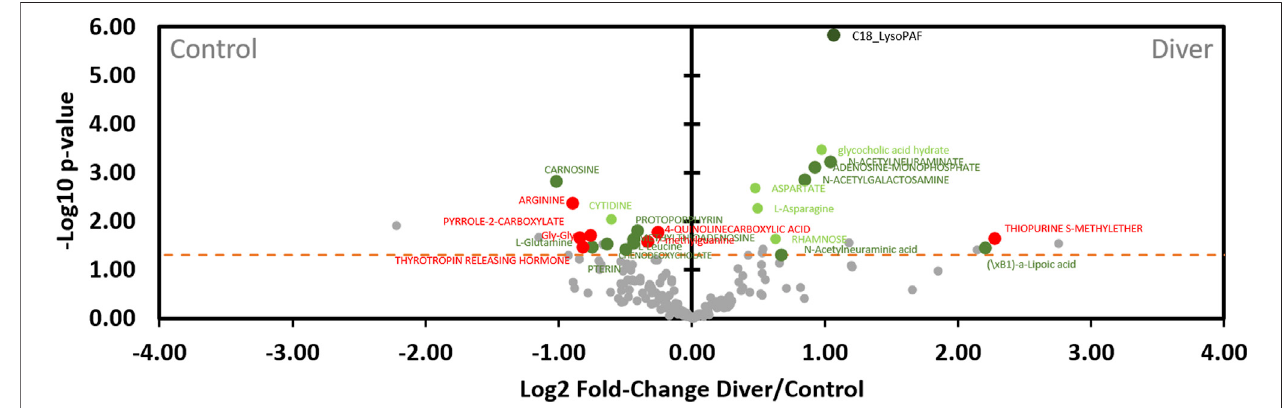
FIGURE 10 | Volcano plot showing metabolomic data in rats ( n = 56) according to the pressure exposure. Fecal metabolites over-expressed in control rats are on theleftandthoseofdiverratsareontheright.Thedashedlineshowswhere p =0.05withpointsabovethelinehaving p < 0.05andpointsbelowthelinehaving p > 0.05. ColorsofthedotsareinaccordancewiththeVenndiagramandwhosesigni fi canceistrueaccordingtothe2-wayANOVA.ReddotsareforDiet*Pressure*Interaction,for example. Grey dots are not signi fi cant according to the 2-way ANOVA and the post-hoc testes.